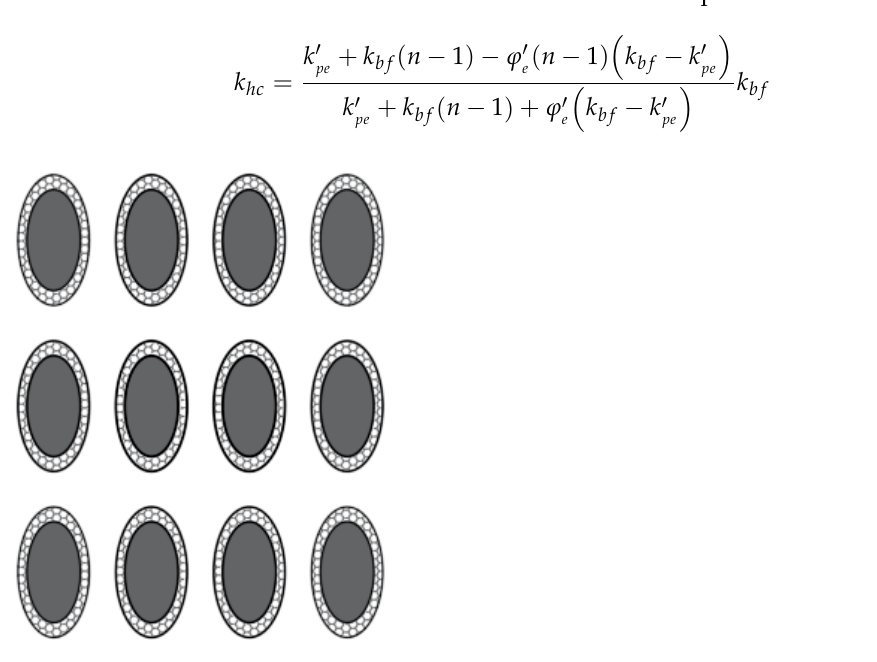
Figure A1. Configurations of equivalent particles not aggregated.